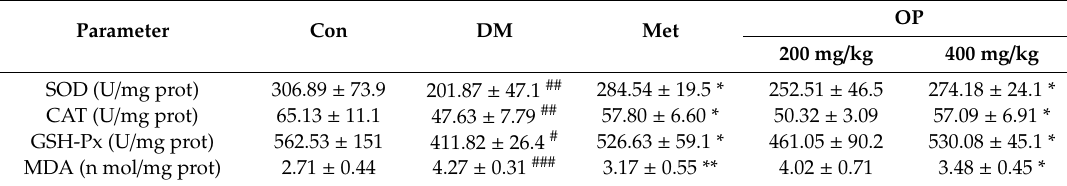
Table 2. E ff ects of OP on the activity of antioxidant enzymes in serum and liver.